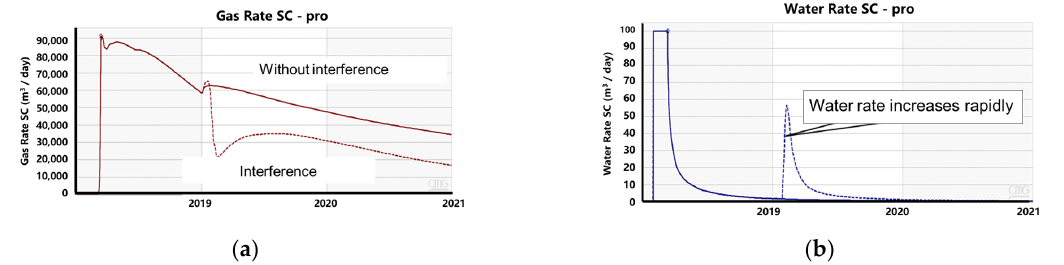
Figure 6. Comparison of gas rate and water rate of Scenarios 1 and 2. ( a ) Gas rate. ( b ) Water rate.